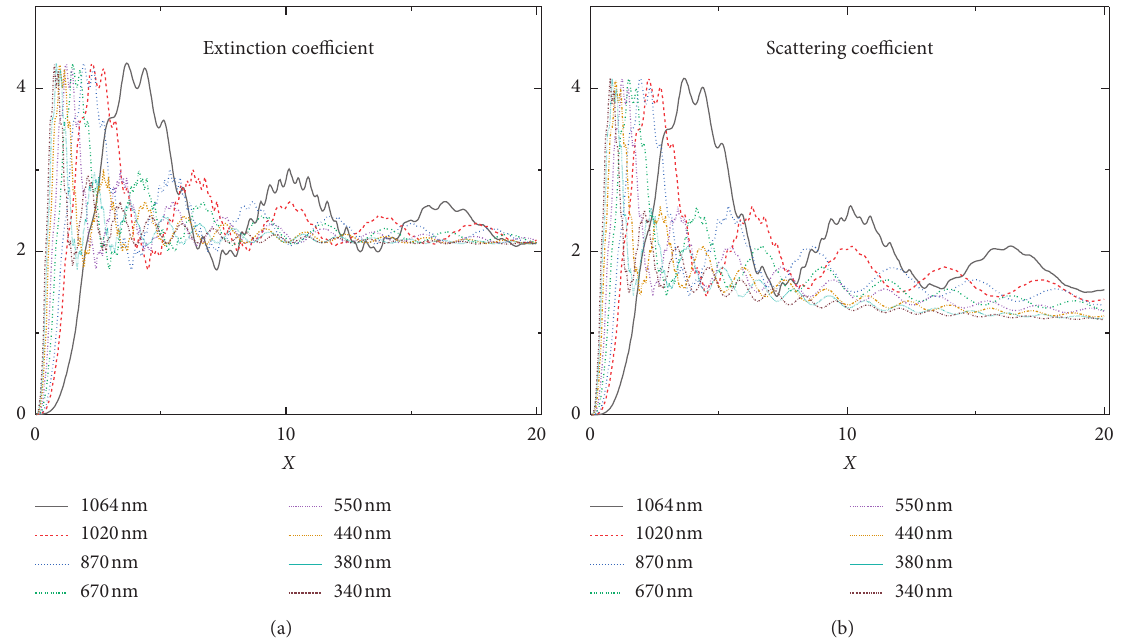
Figure 1: The efficiency factors of extinction and scattering of Mie